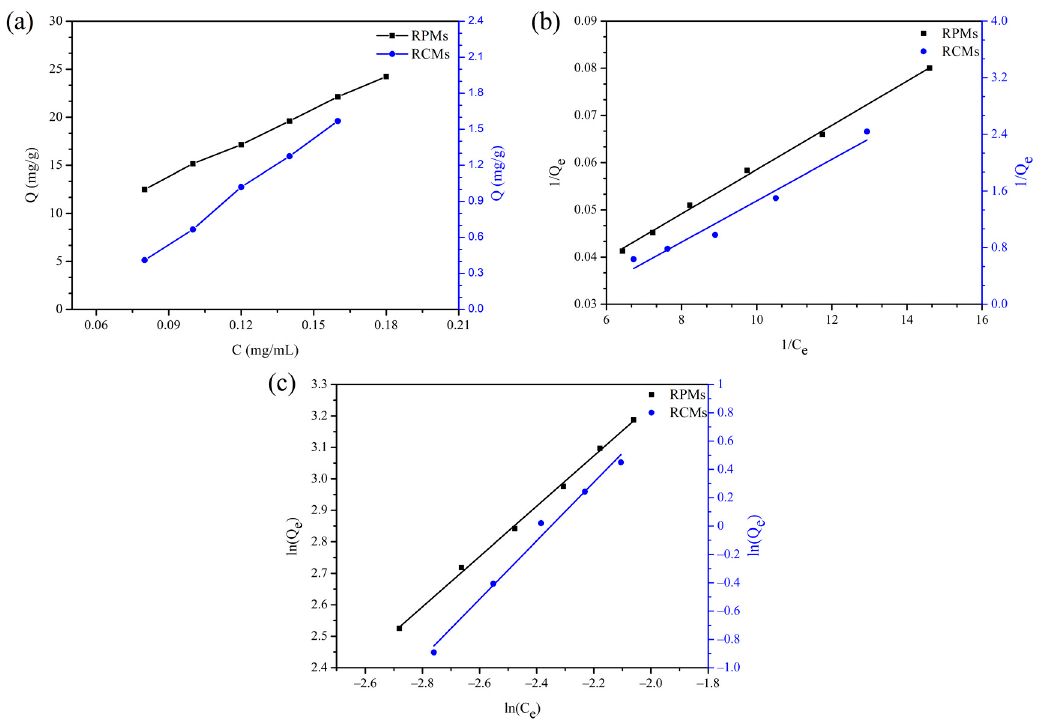
Figure 7. Adsorption thermodynamics of dencichine on RCMs and RPMs. ( a ) Adsorption isotherms; ( b ) Langmuir isotherm model; ( c ) Freundlich isotherm model.